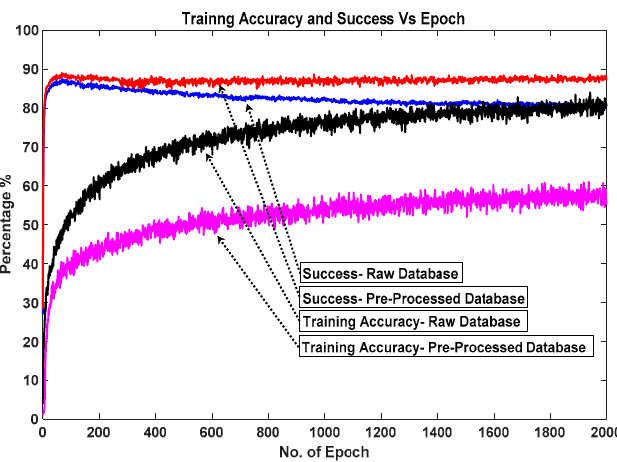
Figure 8. Simulation results for RSS fingerprint database with and without pre-processing.